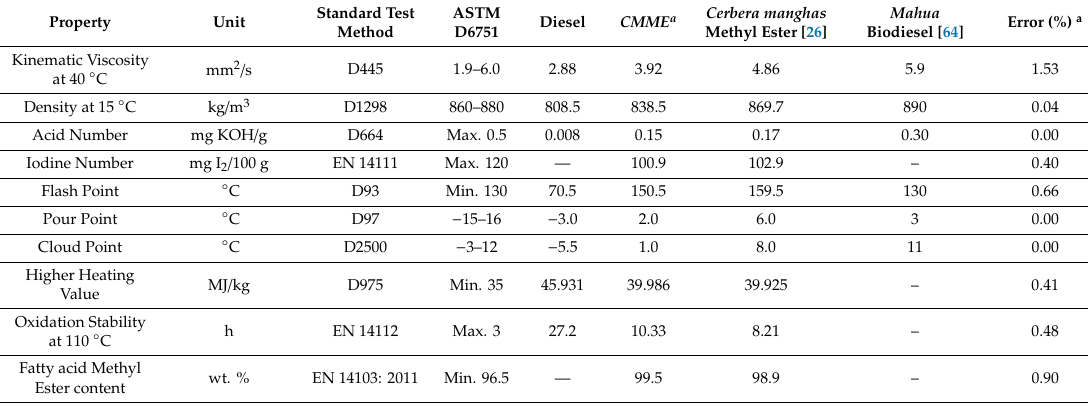
Table 9. Comparison of the physicochemical properties between CMME and